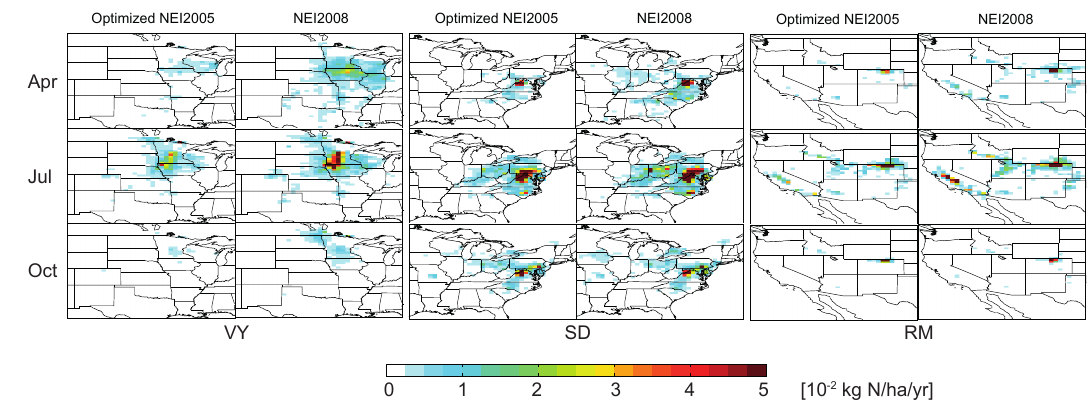
Figure 12. Map of sensitivities of J p to NH 3 emissions for three selected Class I areas (VY, SD, and RM) for two different NH 3 emission inventories (optimized NEI2005 and default NEI2008) in each